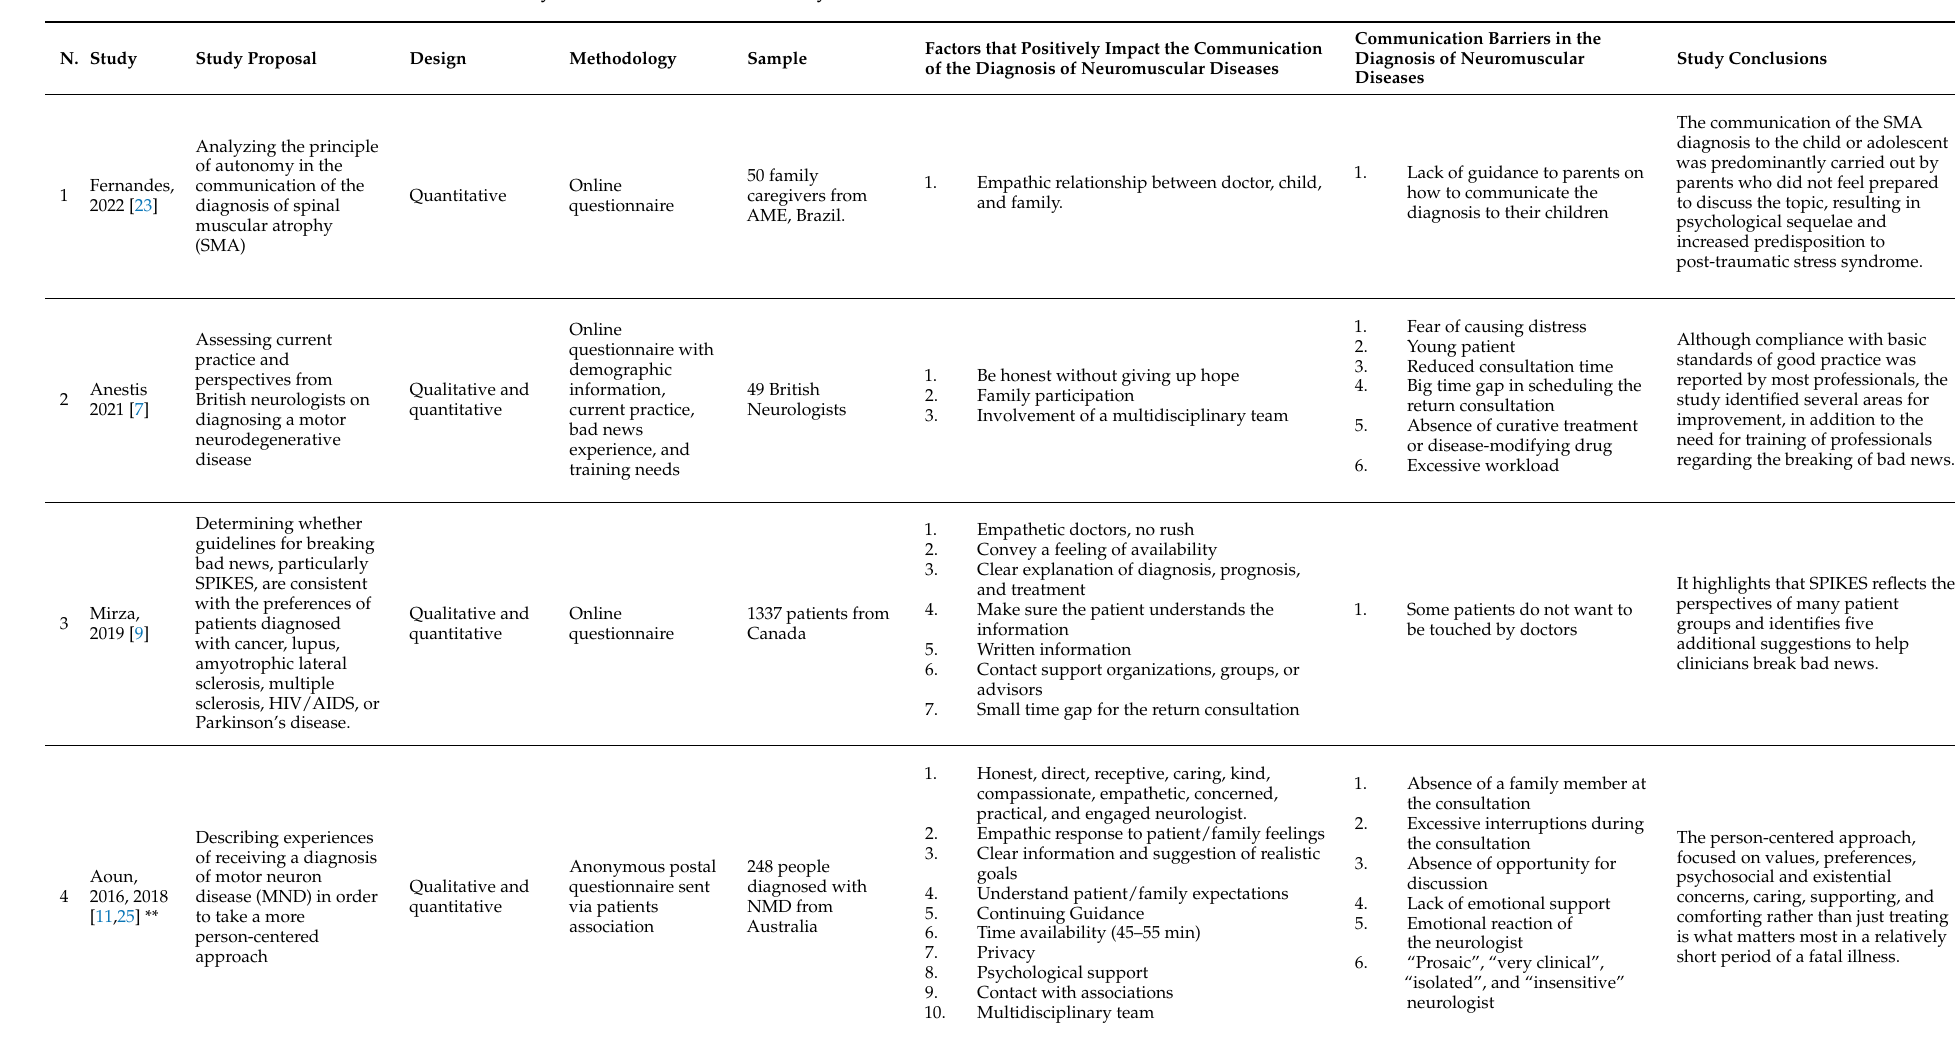
Table 2. Summary of studies selected in the systematic